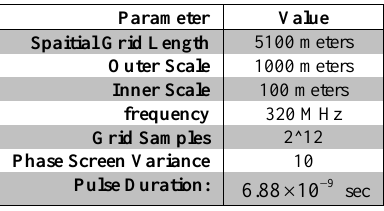
Table 1: Simulation Input Parameters